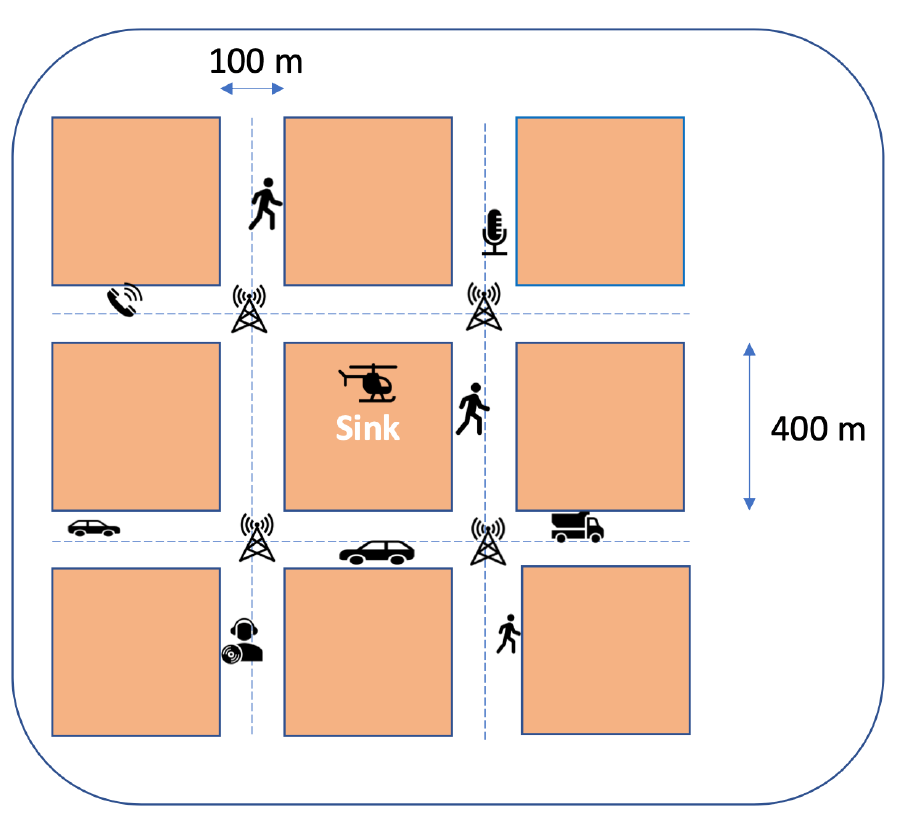
Figure 4. M-Grid mobility